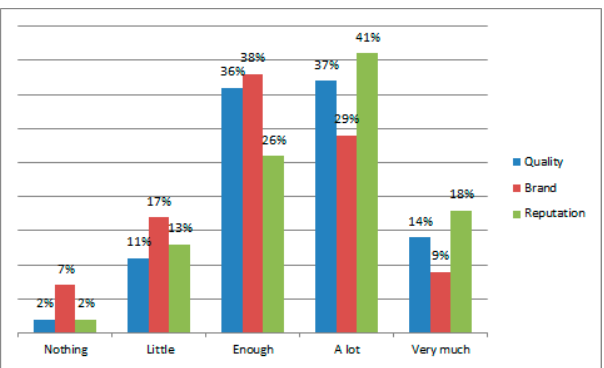
Figure 2. Website variables affecting trust of online reviews.